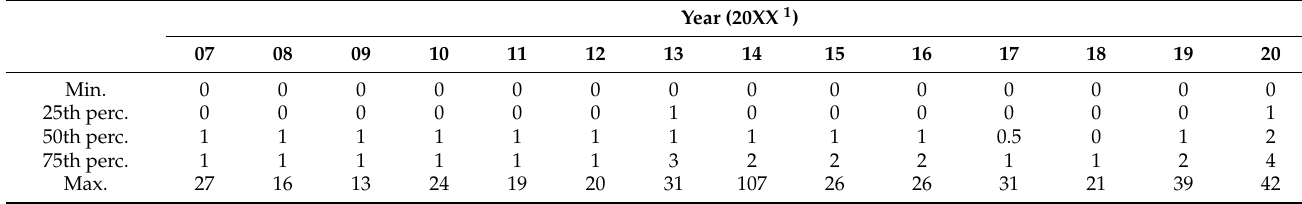
Table 3. Characteristics of the 1618 block maxima by year.